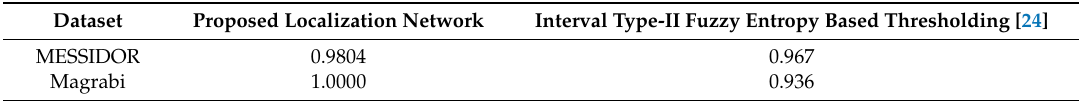
Table 5. Comparing the localization